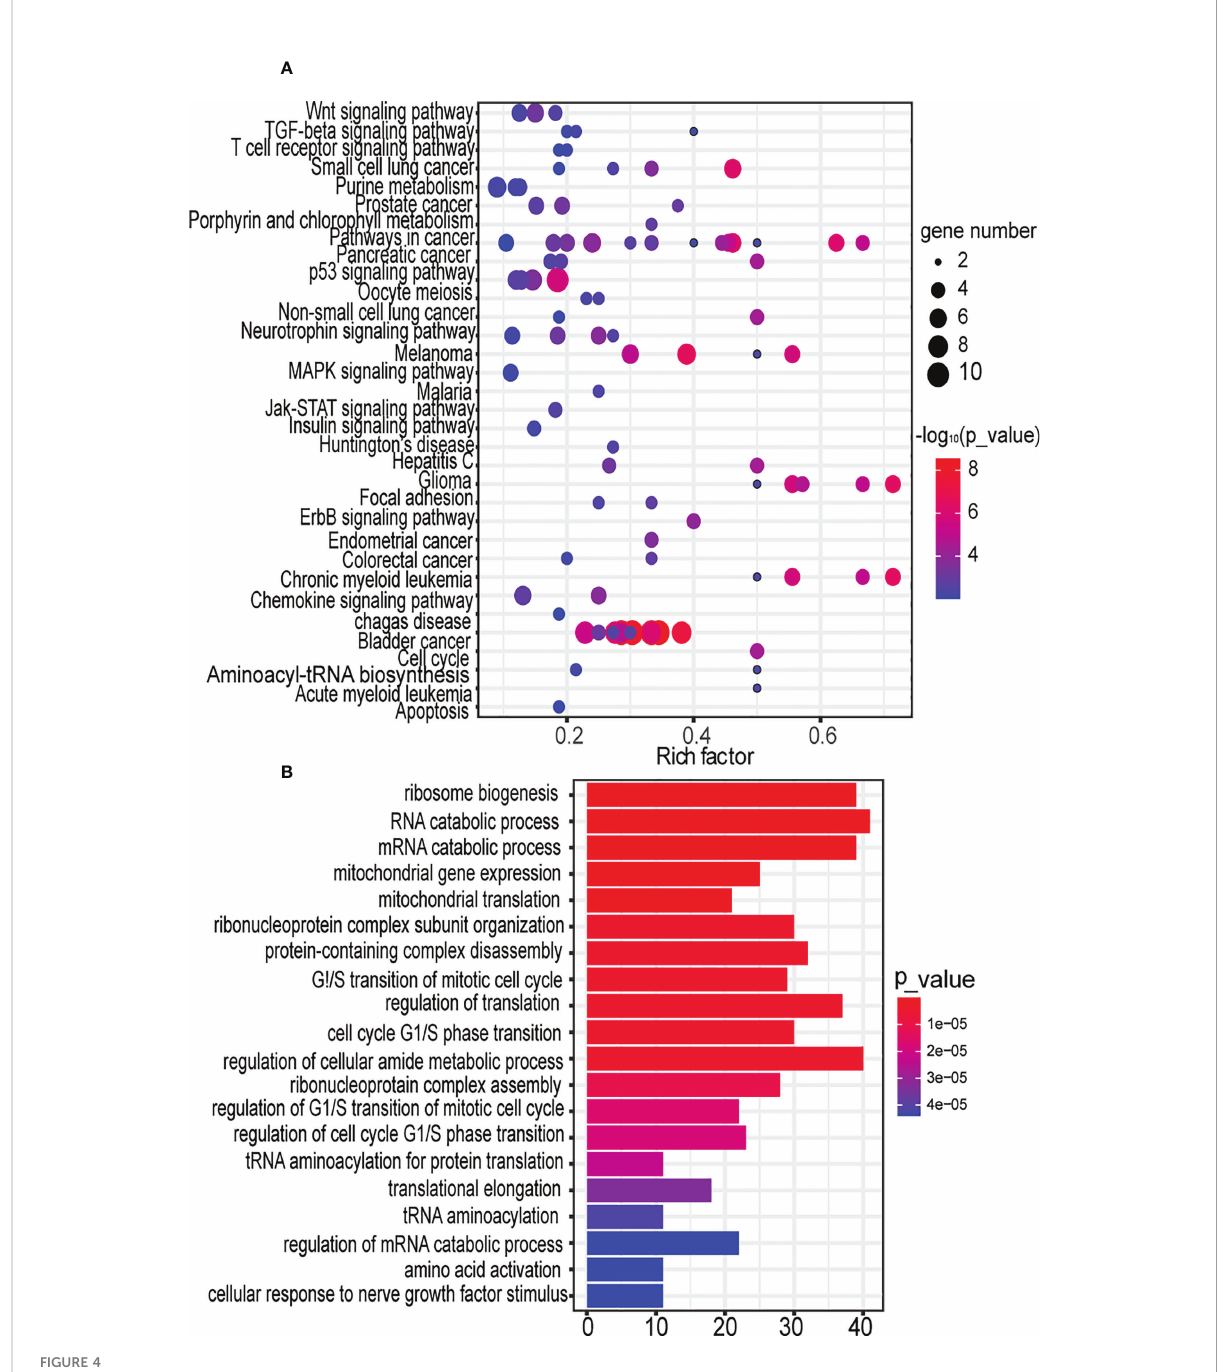
FIGURE 4 Decomposing the function of the key synergistic Ser-miRNAs in the early BTC. (A) . Sub-pathway enrichment analysis of target genes of the tree by KEGG. Dot plot for 104 sub-pathways signatures associated with the target genes of the tree. The y-axis represents entire pathways in KEGG where sub-pathways were located, the x-axis represents the rich factor of the pathway, which meant that the ratio of the number of genes enriched in this pathway (P<0.01) in the target gene to the number of genes belonging to this pathway in human genes. The node size indicates the gene number of the sub-pathway. The color intensity of node corresponds to the negative logarithm of the P-value based on 10. The color of the dots from blue to red indicates the signi fi cance of the sub-pathway, and the redder colors indicate more signi fi cance. (B) . GO analysis of target genes of trees based on their molecular functions, biological processes, and cellular components. The signi fi cant terms were shown according to the gene counts